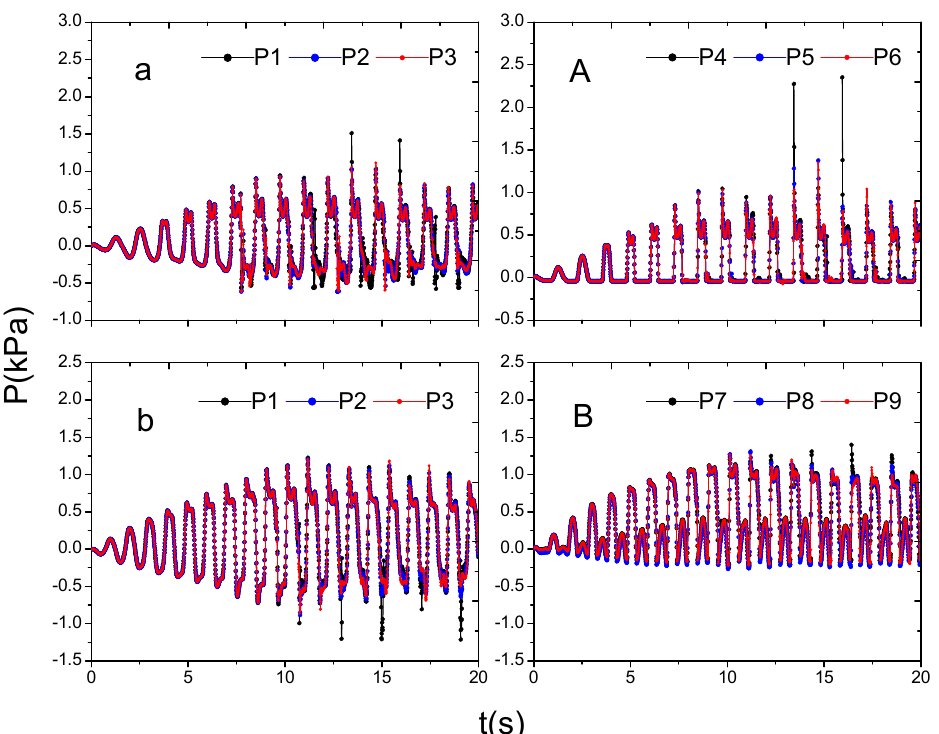
Figure 12. The comparison of impact pressure at different positions at the same height on the side wall. ( a ) h = 90 mm, ω = 1.06 ω 1 , pressure on the bottom, ( A ) h = 90 mm, ω = 1.06 ω 1 , pressure on the free surface, ( b ) h = 200 mm, ω = 0.96 ω 1 , pressure on the bottom, ( B ) h = 200 mm, ω = 0.96 ω 1 , pressure on the free surface.